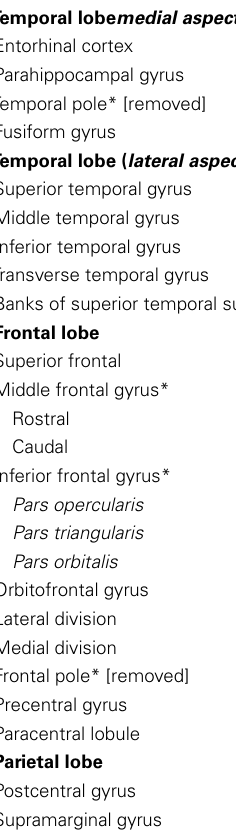
Table 2 | Cortical regions in the DKT labeling protocol. Table 3 | Sulci included in the DKT labeling protocol and their